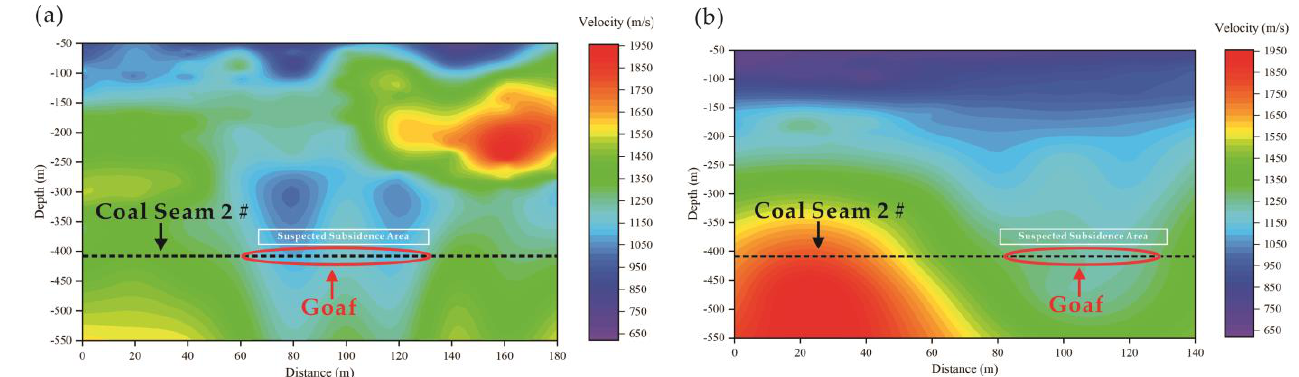
Figure 12. Apparent shear wave velocity profiles of two lines: ( a ) the shear wave velocity profile of WD1 line; and ( b ) the shear wave velocity profile of WD2 line.